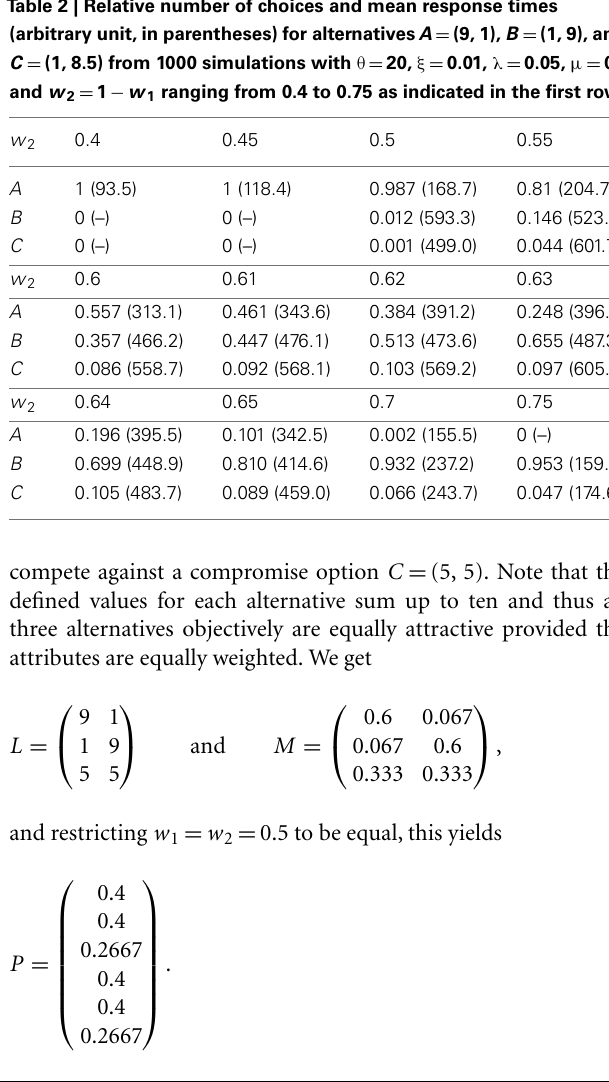
Table 1 | Relative number of choices and mean response times